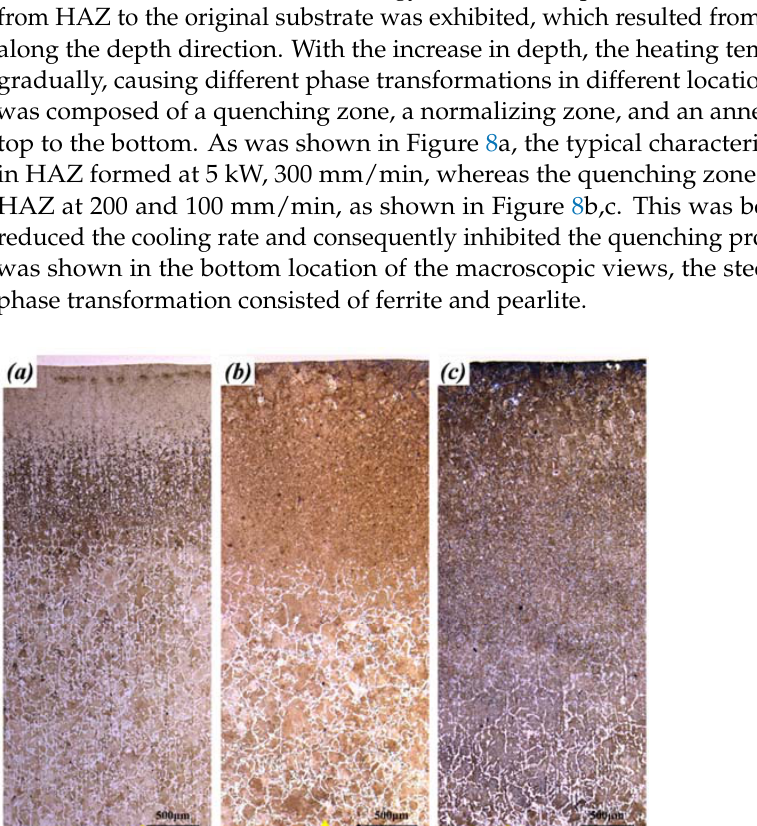
Figure 7. SEM morphologies and EDS analysis of the Ni35 coatings fabricated at 5 kW, 200 mm/min: ( a , b ) SEM morphology, ( c ) EDS result of point 1, and ( d ) EDS result of point 2. (EDS test position indicated by the cross in ( a , b )).